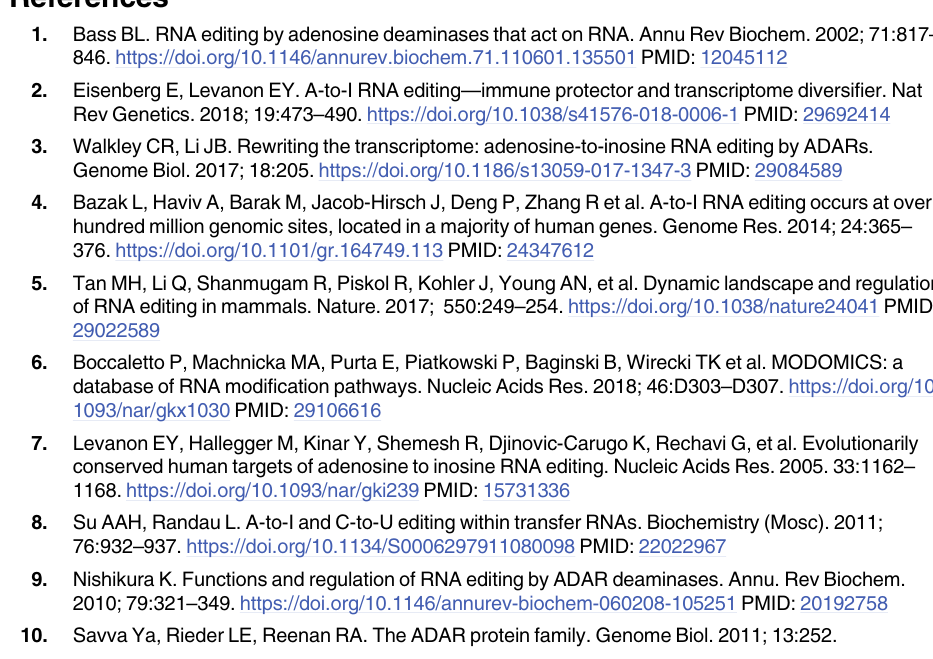
bowhead ( Balaena mysticetus